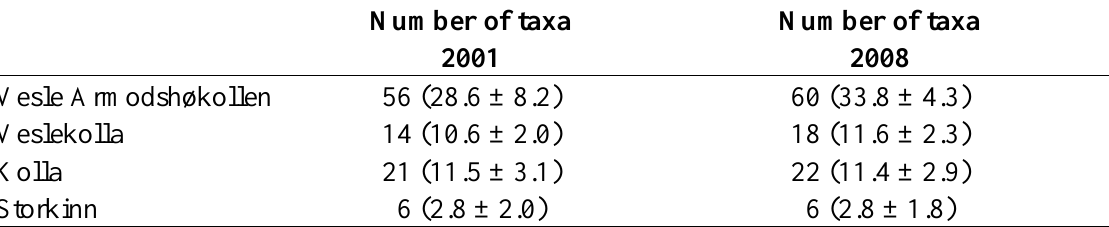
Table 1. Total number of vascular plant taxa at the four study summits in 2001 and in 2008 (mean number for summit area sections with standard deviation in